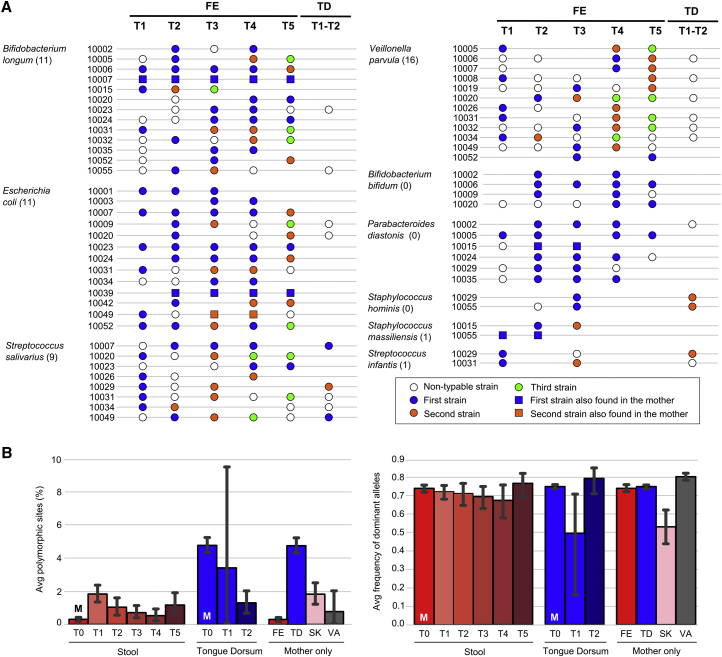
Strain Persistence, Strain Replacement Events, and Strain Heterogeneity(A) Map of the strain dynamics in longitudinal infant stool (FE) samples for selected species (for full map, see Figure S6). The tongue dorsum (TD) column shows the species for which at least one of the strains found in stool was also present on the tongue dorsum. Blue circles represent the first strain of the species identified in the infant, whereas orange and green circles denote the second and third longitudinally identified strain, respectively. Empty circles refer to species for which strain profiling was not possible in the specific sample. Missing samples and samples lacking the species are not reported. The total number of infant replacement events observed in each species is shown in parentheses.(B) Mean percentages of polymorphic sites and average frequency of the dominant alleles in polymorphic sites for each body site and time point (“M” indicates maternal samples). Color coding is as per Figure 1. p values are reported in Table S4. Error bars refer to 95% confidence intervals.